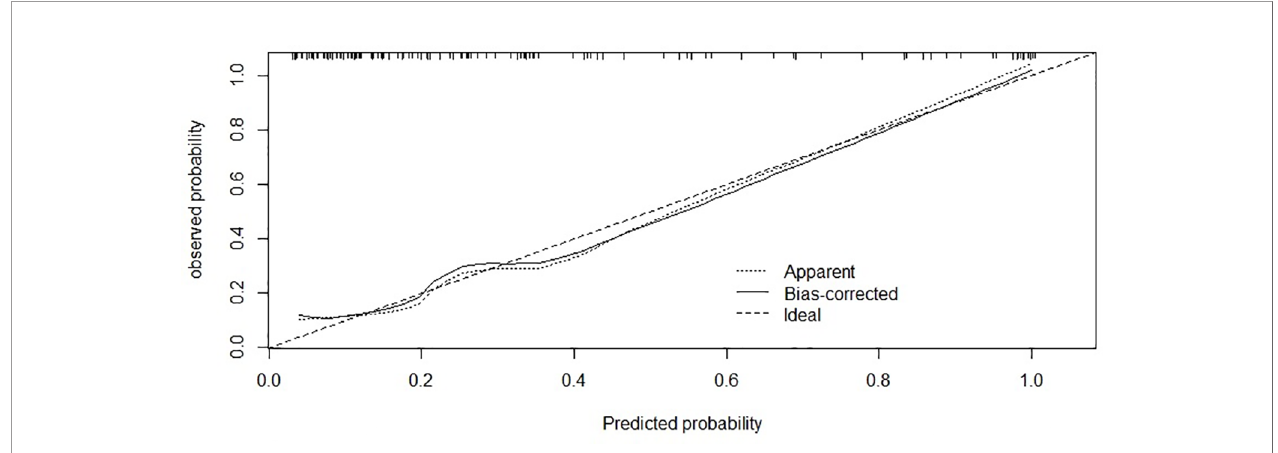
FIGURE 4 | Calibration of the nomogram for risk of POF. The x-axis shows the predicted probability of POF, and the y-axis shows the observed probability of POF. C-index:0.85; (95% con fi dence interval